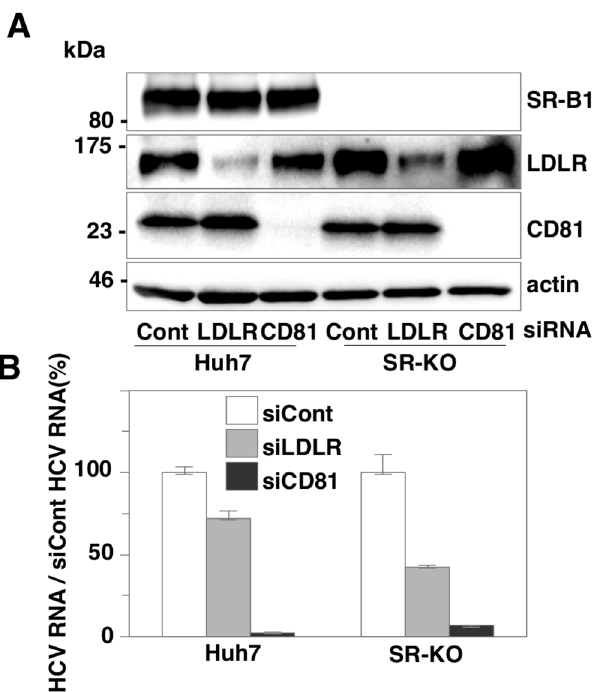
Fig 2. Deficiencies of SR-B1 and LDLR impair HCV entry. (A) Expressions of SR-B1, LDLR and CD81 in parental and SR-KO Huh7 cells transfected with siRNAs targeting LDLR or CD81 were determined by immunoblotting analysis at 48 h post-transfection. (B) Parental and SR-KO Huh7 cells were infected with HCVcc at an MOI of 1 at 48 h post-transfection with siRNAs targeting LDLR or CD81, and intracellular HCV RNA levels were determined at 24 h post-infection by